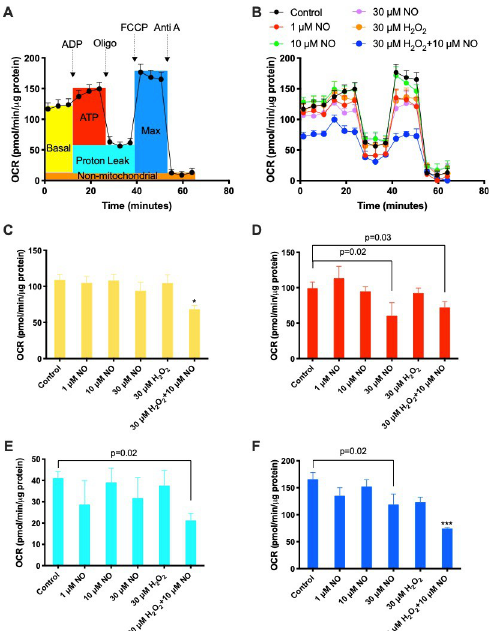
Fig 5. Effects of NO on mitochondrial oxygen respiration. n = 5. Seahorse measurements of the effects of NO on mitochondrial oxygen consumption rate (OCR). A) Example (control group) for the Seahorse assay of mitochondrial OCR. B) Representative OCR traces of mitochondria in the absence and presence of NO and/or H 2 O 2 . C) Basal respiration. D) ATP-linked respiration. E) Proton leak. F) Maximal respiration. � p < 0.05, ��� p < 0.001 vs Control (One-way ANOVA). Given p value represents the result of paired